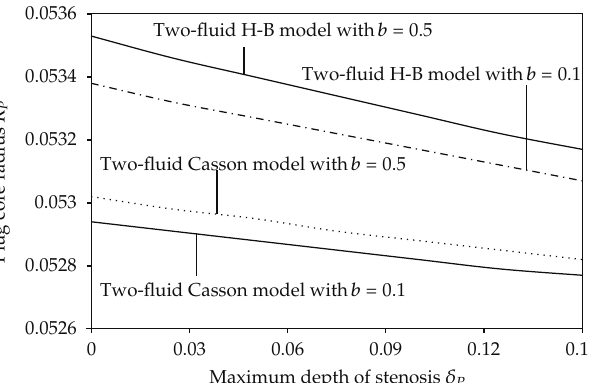
Figure 3: Variation of plug core radius with maximum depth of the stenosis for two-fluid H-B and Casson models and di ff erent values of amplitude of the artery radius with ψ (cid:7) − 0 . 1 , t (cid:7) 45 ◦ , δ P (cid:7) θ (cid:7) 0 . 1 , B (cid:7) 1 , e (cid:7) 0 . 5 , φ (cid:7) α H (cid:7) α C (cid:7) 0 . 2 , ω (cid:7) 1 , z (cid:7) 2 . 3, and β (cid:7) n (cid:7) 0 . 95.